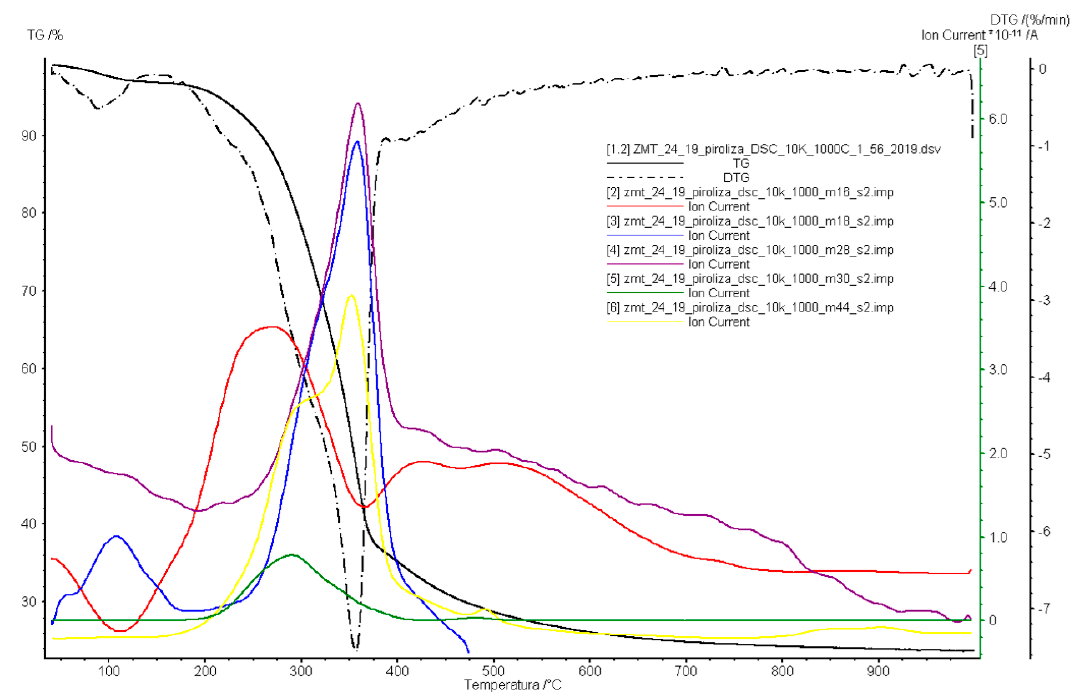
Energies 2019 , 12 , x FOR PEER REVIEW Figure 5. TG and DTG curves, and ion current intensity for the sample ZMT / 24 / 2019 (own research). Figure 5. TG and DTG curves, and ion current intensity for the sample ZMT/24/2019 (own research).